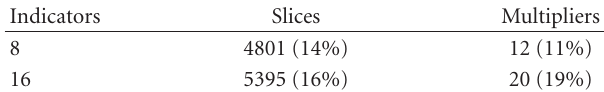
Table 2: Synthesis result with fixpoint